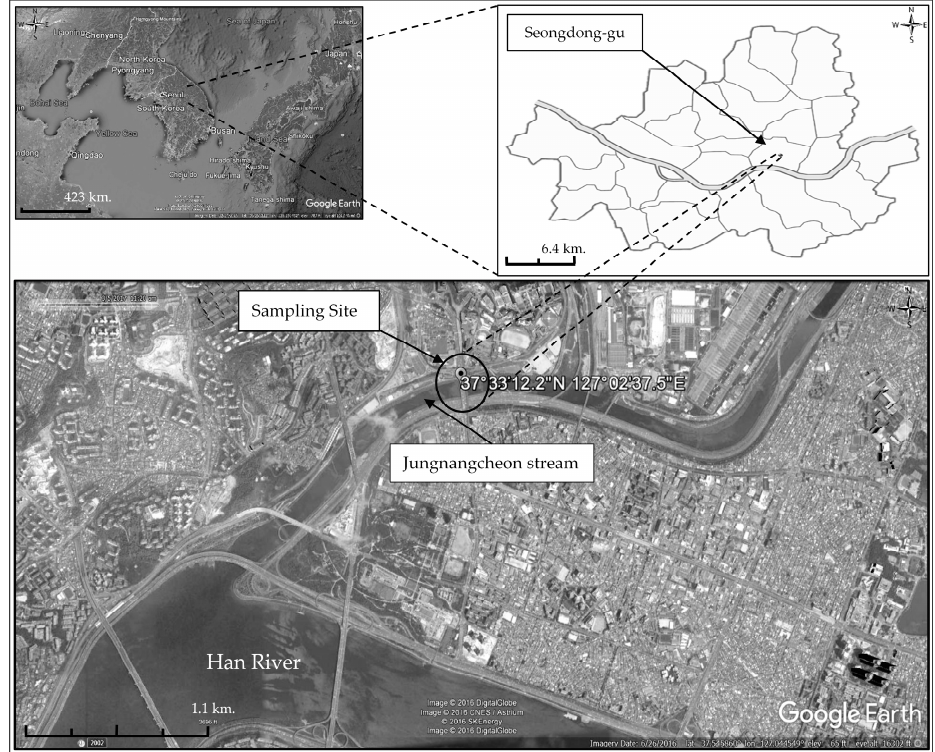
Figure 1. Geographical location of sampling site ( Jungnangcheon stream).